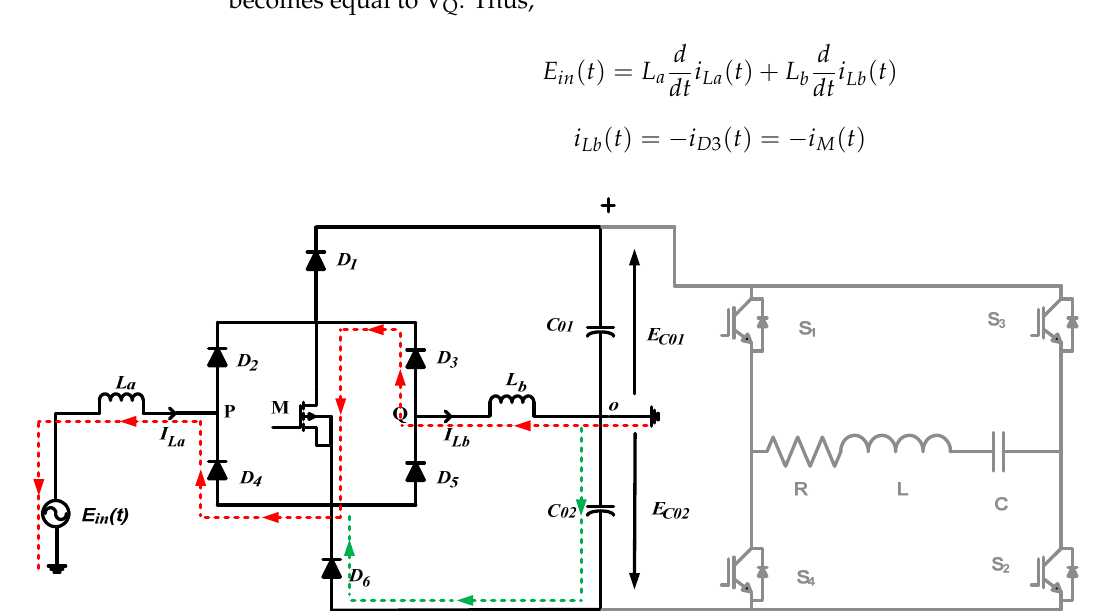
Figure 4. Proposed MVR with negative current path and closed switch.